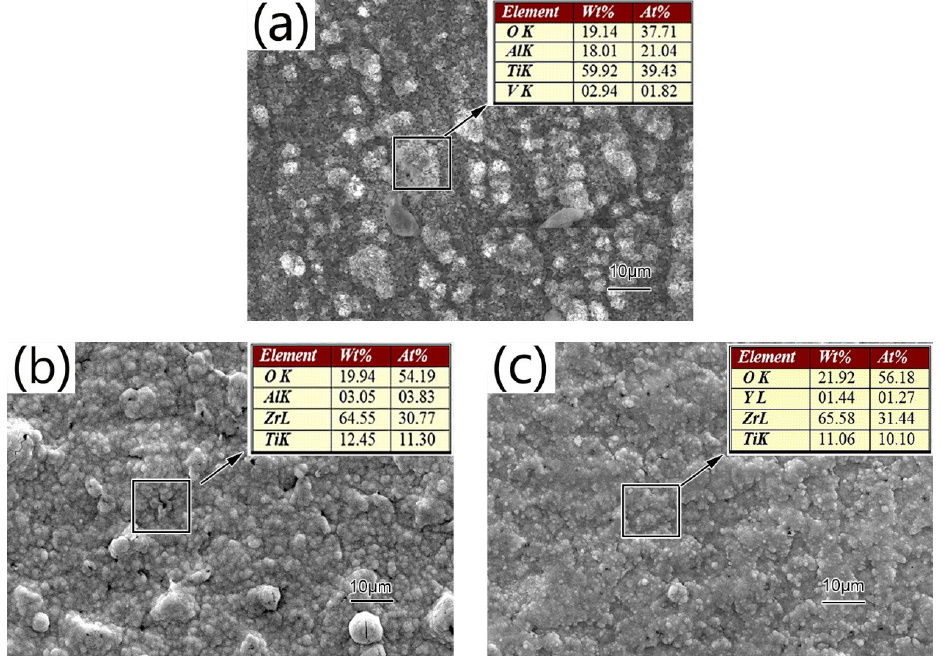
Figure 9. Surface morphology and EDS pattern of specimens at 800 °C for 100 h: ( a ) TiAl substrate; ( b ) Zr coating; ( c ) Zr-Y coating.